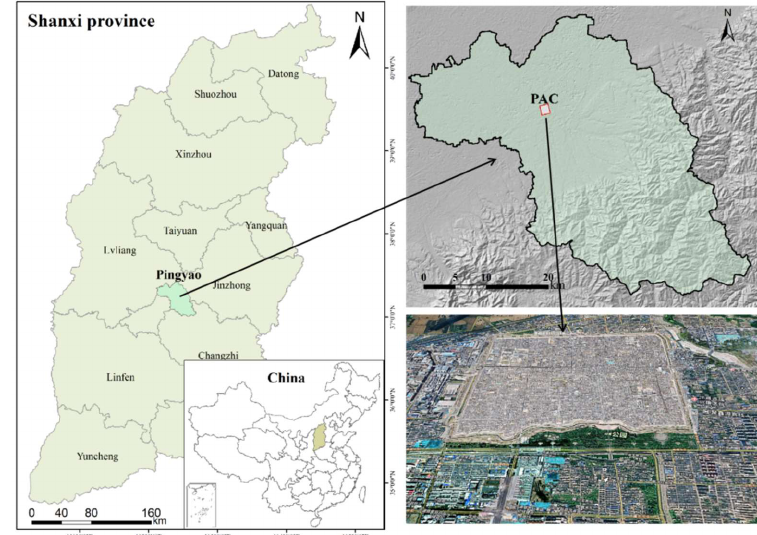
Figure 2. Location of the study